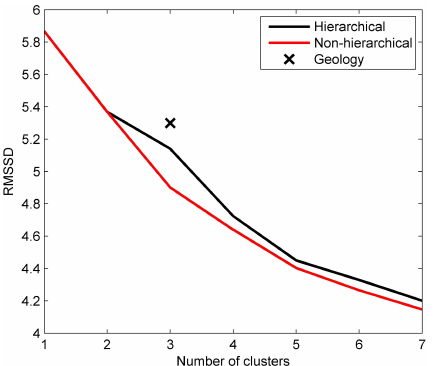
Figure 4. RMSSD as a function of the number of clusters for the hi- erarchical and non-hierarchical k -means clustering algorithms and for a three-fold classification based on geology alone.